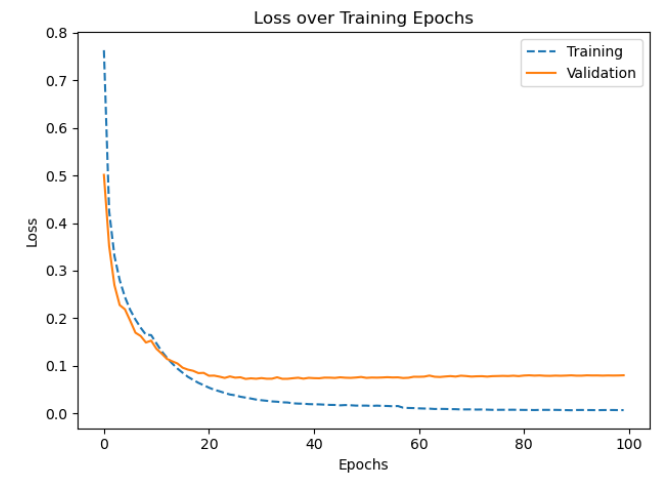
Figure 8. The progress of the loss for the final training for 100 epochs. The progress shows an asymptotic behavior after around about 40 epochs. The progress corresponds to the progress of the score. Table 1. An overview about the scores and best epochs of the networks trained with one sensor modality left-out. For the sake of comparison, the first row shows the baseline values of the network trained with all sensor modalities. Left-Out Sensor Best Epoch None 77 Acceleration 50 Gravity 50